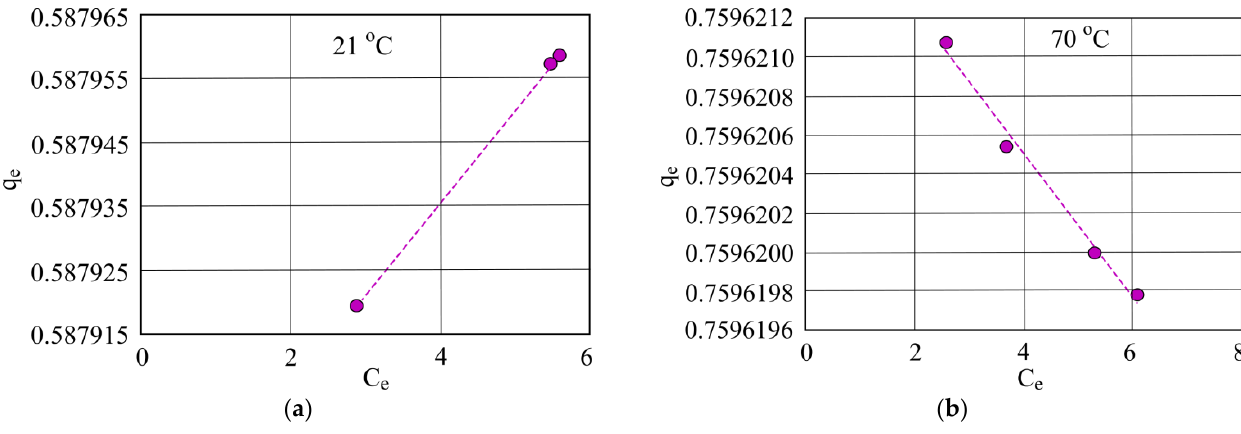
Figure 14. Freundlich isotherm when investigated water temperature is at ( a ) 21 °C and ( b ) 70 °C using hydrophobic peat sorbent.